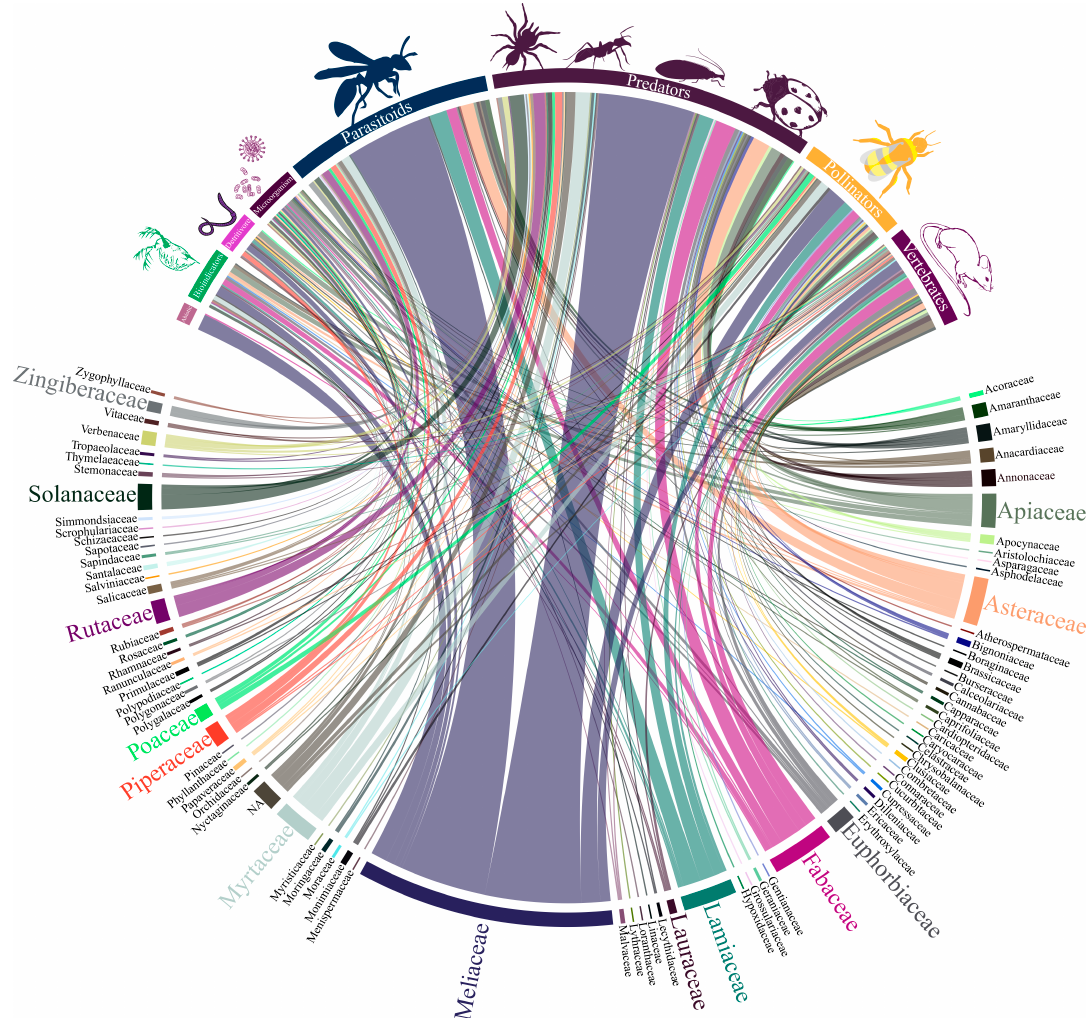
Figure 4. Interaction among the diversity of plant families and non-target organism from the literature survey of papers on botanical insecticides (n = 2543); the bar and line thickness under each taxon / group or connecting them corresponds to the relative number of papers dealing with the said taxa and group of non-target